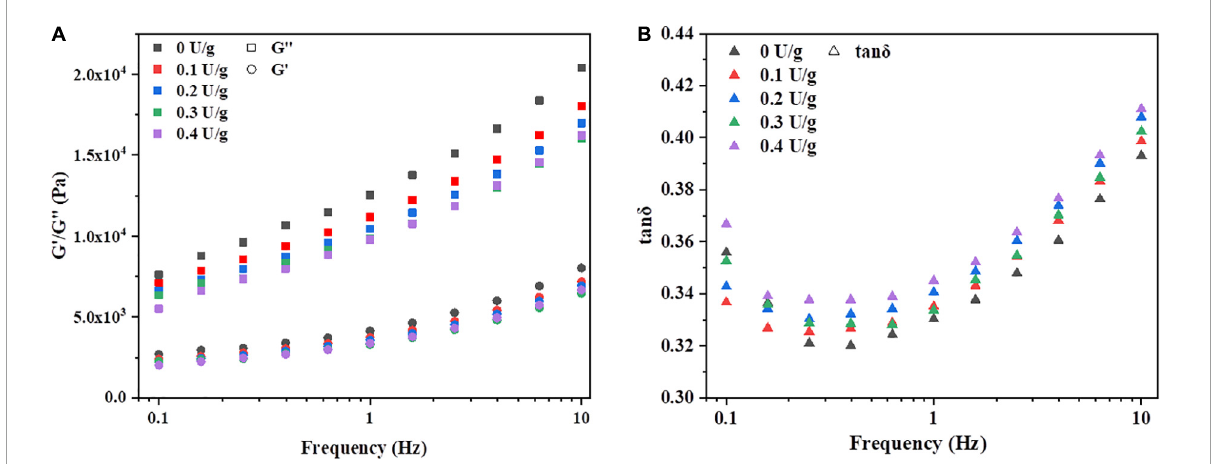
FIGURE1 Variation in (A) storage modulus (G’), loss modulus (G"), and (B) tan δ of dough with or without